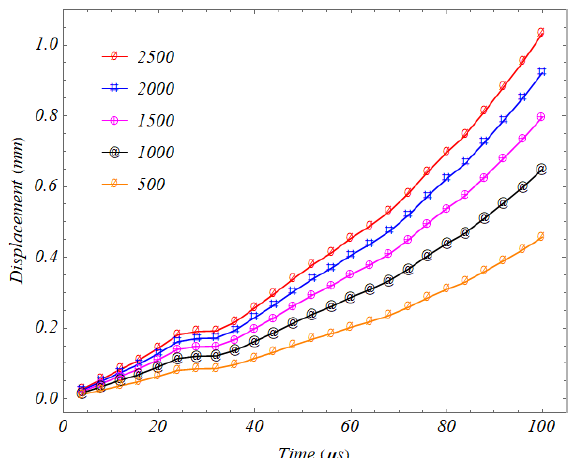
Fig. 32. Displacement against time for various drop distances with two cell phone casing laminates.